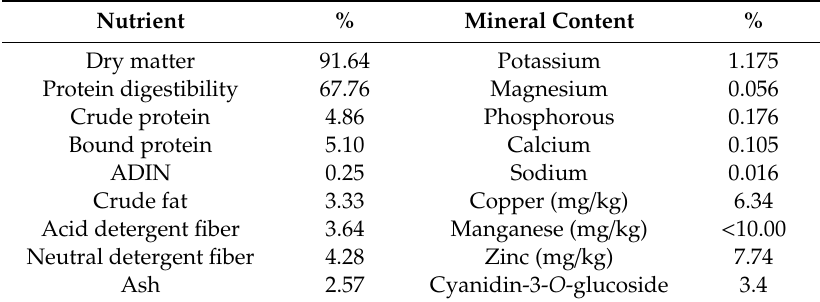
Table 1. The nutritional composition of lyophilized powder of haskap berry cv. Tundra.